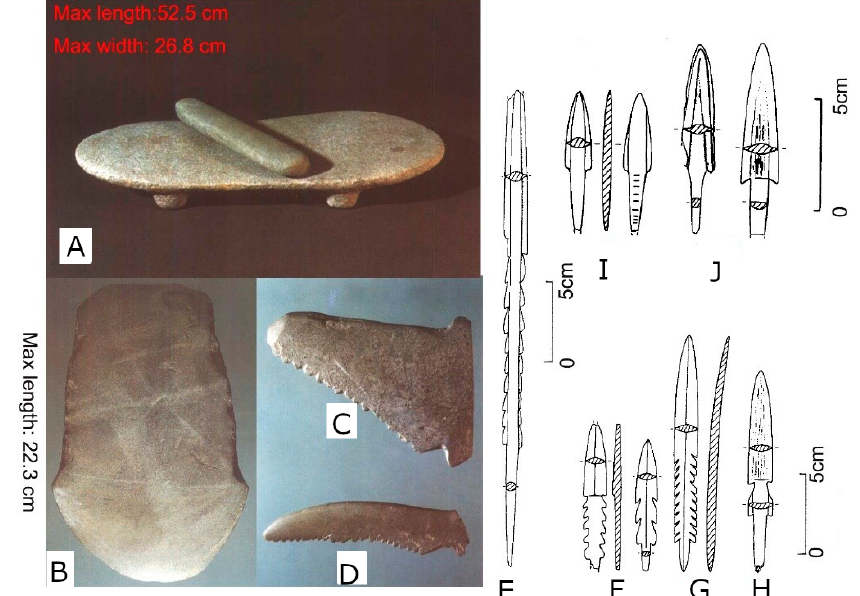
Figure 5. Toolkits of the Jiahu site which show the intensity of the techniques of food acquisition (( A ): stone slab and roller, the size of the stone slab is marked in the figure; ( B ): stone hoe; ( C )–( D ): stone sickle; ( E )–( H ): bone harpoon; ( I )–( J ): arrowhead, after [47]).